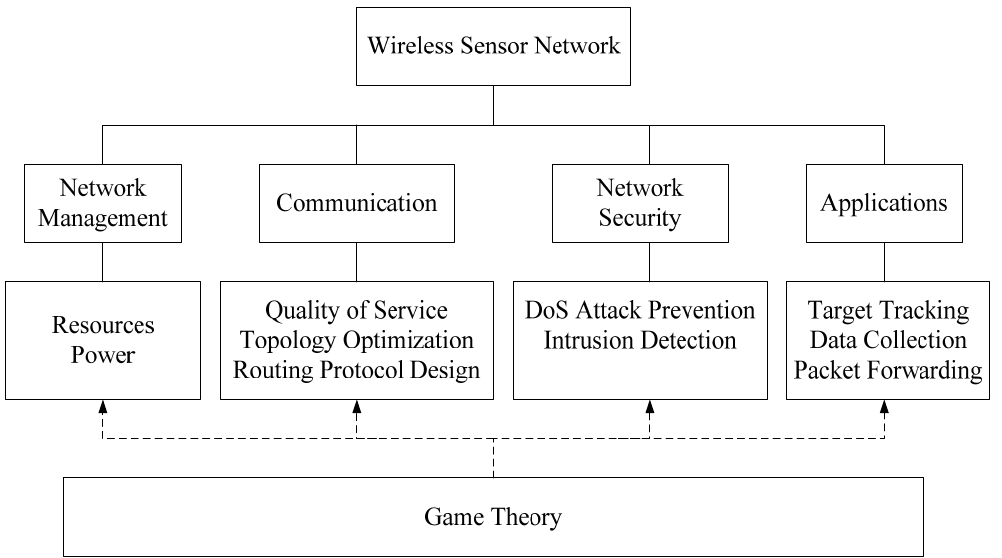
Figure 3. An illustration of the relation between WSN and game